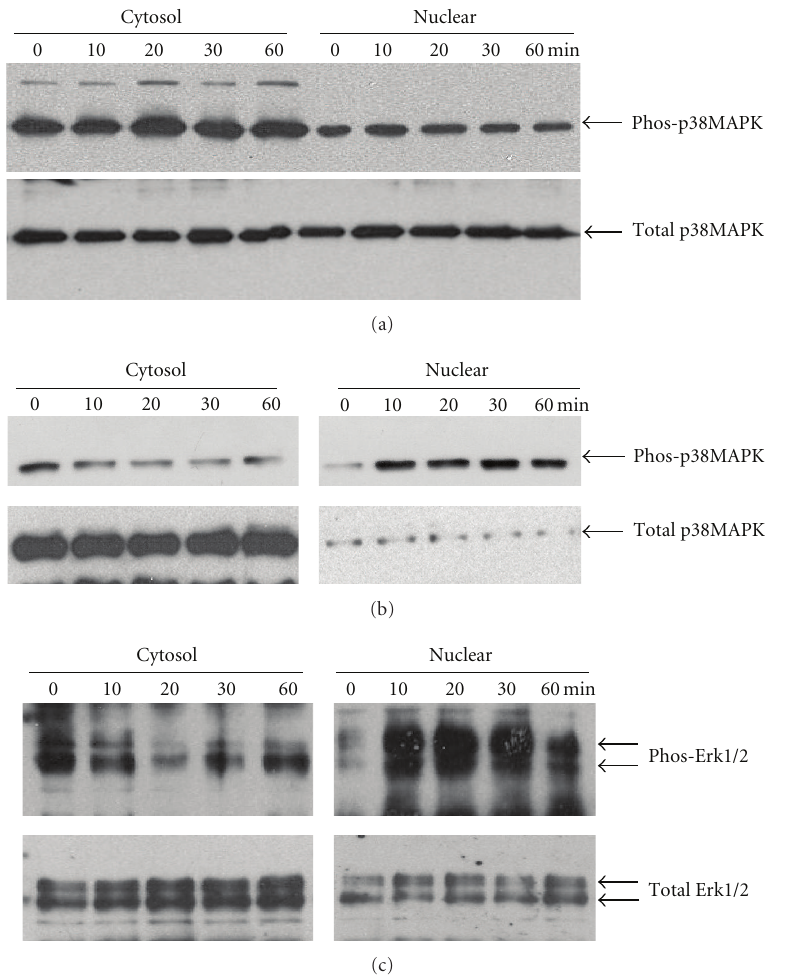
Figure 2: Heat stress activates phosphorylation of Erk1/2 and p38 MAPK. (a) Representative immunoblot of p38 MAPK phosphorylation and nuclear accumulation by heat stress (40 ◦ C, 20 minutes) in mesothelial cells. Similar results were obtained in two additional experiments. Coomasie blue was used to control equal protein loading (loading control). (b) representative immunoblot of constitutive p38 MAPK phosphorylation in PDMM cells (LO68). Similar results were obtained in the other two PDMM cell lines. (c) representative immunoblot of Erk1/2 phosphorylation and nuclear accumulation after heat stress (40 ◦ C, 20 minutes) in PDMM cells (LO68). Similar results were obtained with two other PDMM cell lines and in mesothelial